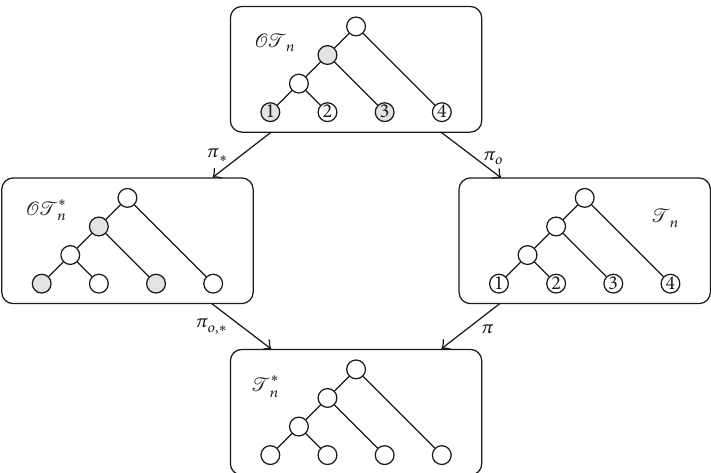
Figure 1: An example of images under the forgetful mappings between (ordered and unordered) cladograms and tree shapes. In the ordered objects, the ordering is represented by the nodes’ colors: gray ≺